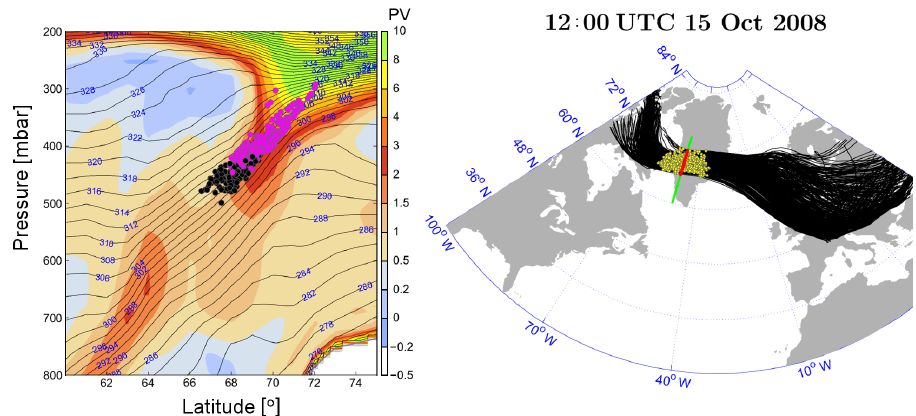
Figure 14. Right panel: intrusion trajectories (black lines) intersecting a vertical control surface (green line) above the west coast of Greenland at three different times; left panel: intersection points of the trajectories on the control surface (see text); the blue contour lines are isentropes (in